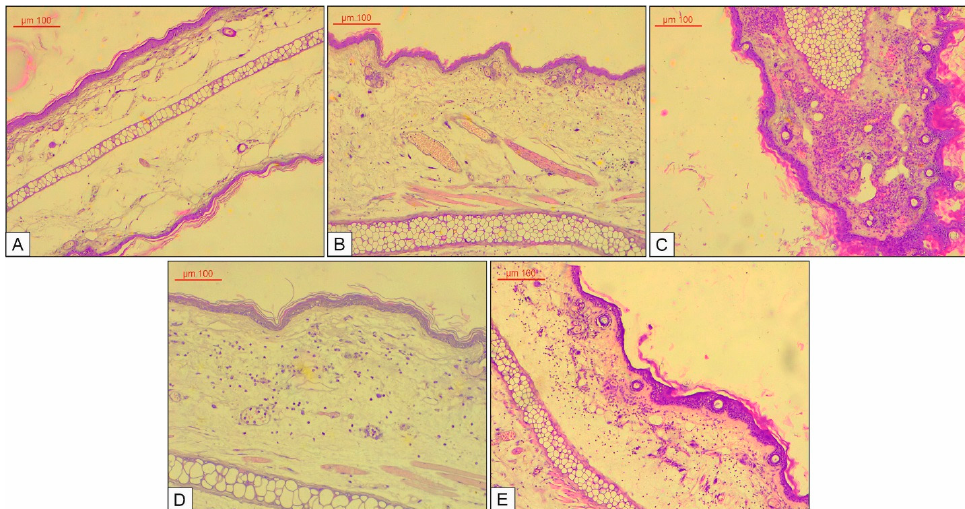
Figure 9. Histological aspects of the mice’s ear skin, hematoxylin and eosin (HE) staining: ( A ) Control group–with no intervention, magnification ×10; ( B ) acetone group—edema, discrete interstitial inflammatory infiltrate, magnification ×20; ( C ) 12-o-tetradecanoylphorbol − 13-acetate (TPA) group— marked dermo-epidermal and interstitial inflammatory infiltrate, magnification ×20; ( D ) TPA